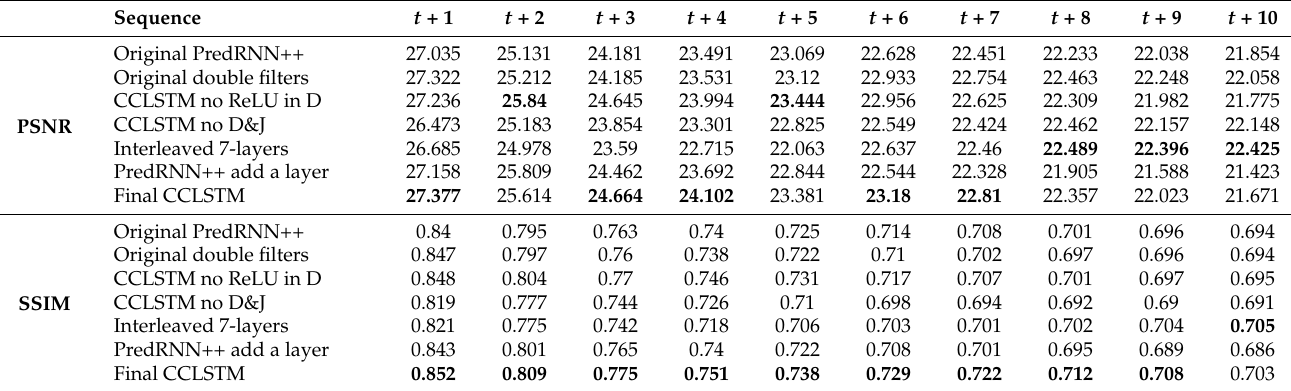
Table 2. The first six rows in the PSNR (dB) and SSIM columns in the table correspond to the above six models, respectively, and the seventh row is the final scheme. “D” means double-layer convolution filter. “J” means jumpers. The bold numbers in the table indicates the maximum value of the